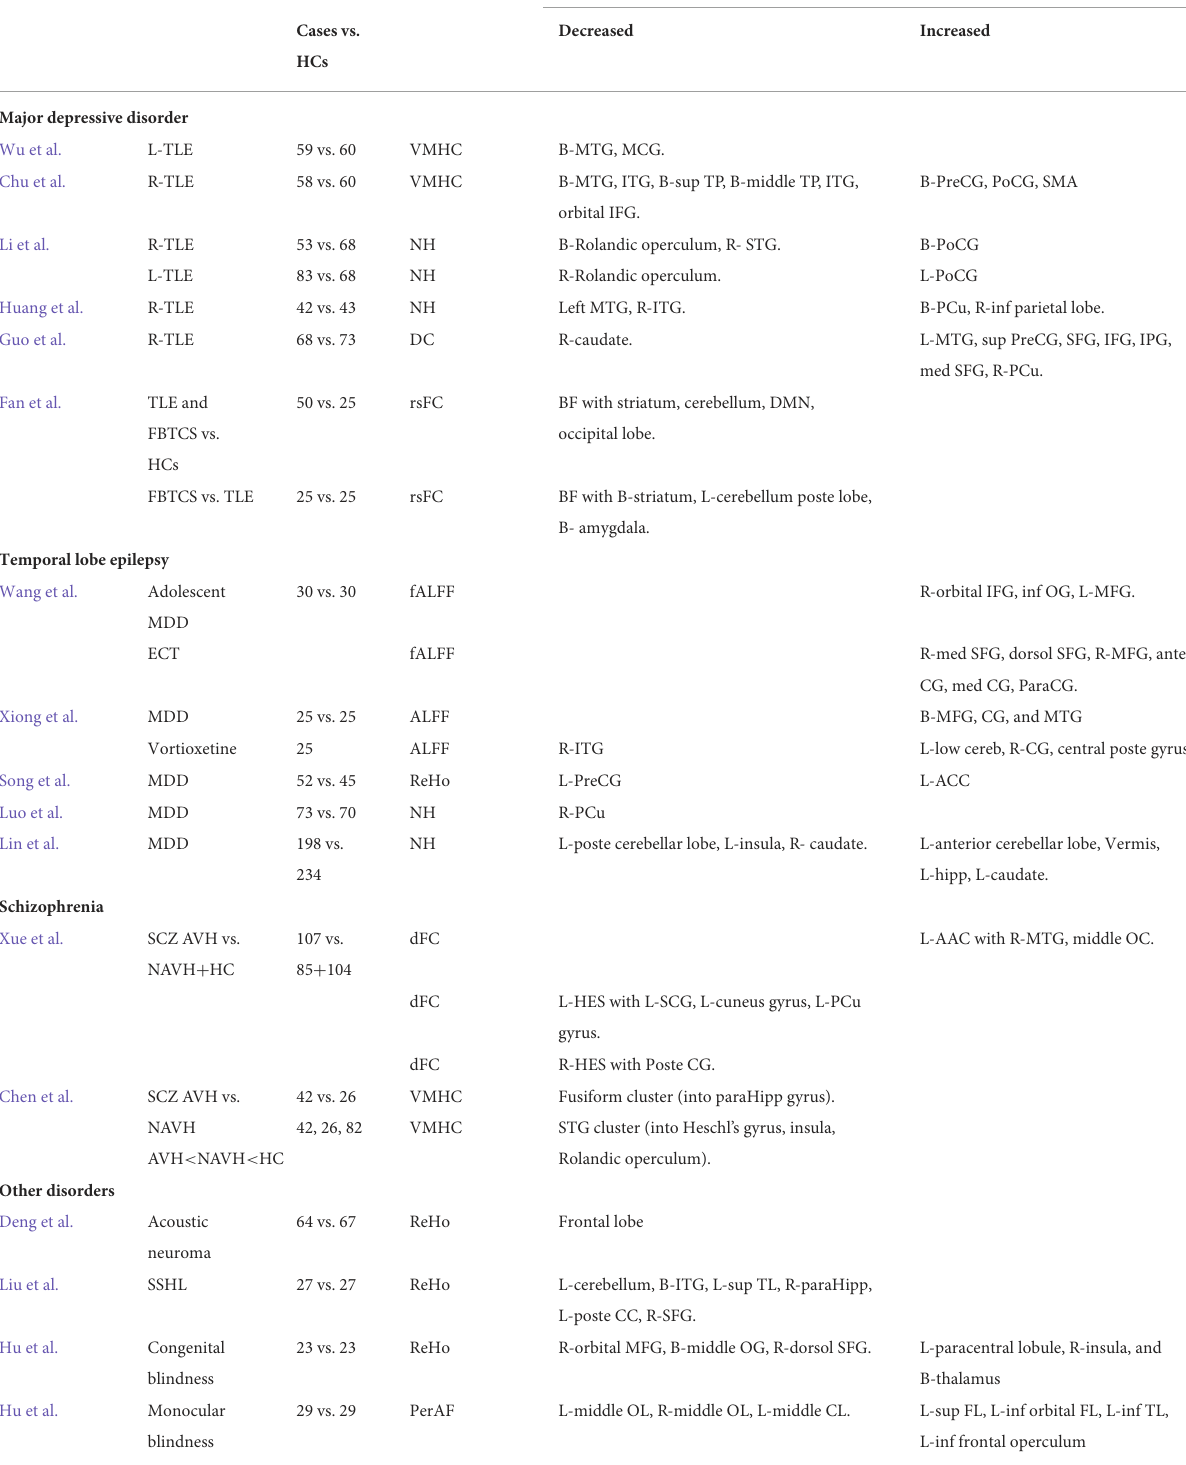
TABLE 1 rs-fMRI study of temporal lobe dysfunctions in temporal lobe epilepsy, major depression, schizophrenia and other